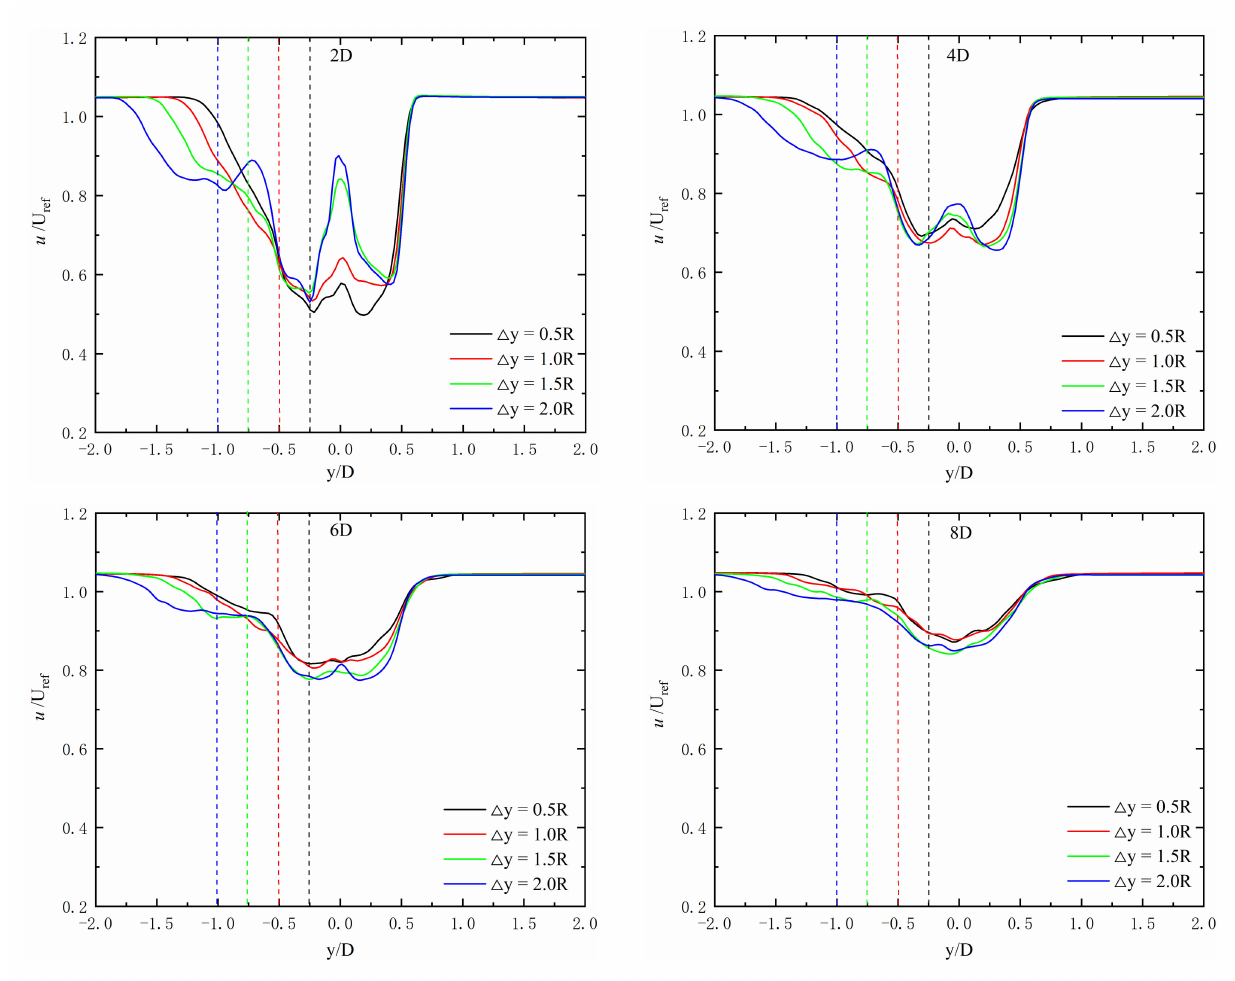
Figure 12. Normalized velocity profiles behind WT-2 at different axial locations in the hub height. The dotted line represents the wake centerline of the WT-1 under each ∆ y (U ref = 11.4